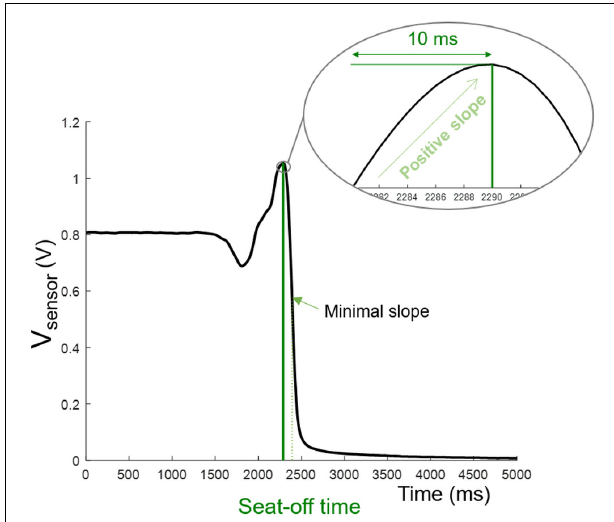
FIGURE 3 | Seat-off detection. Starting from the time of occurrence of the steepest negative slope, the signal was analyzed backwards to identify the time when the slope changed sign and remained positive for at least 10 ms.